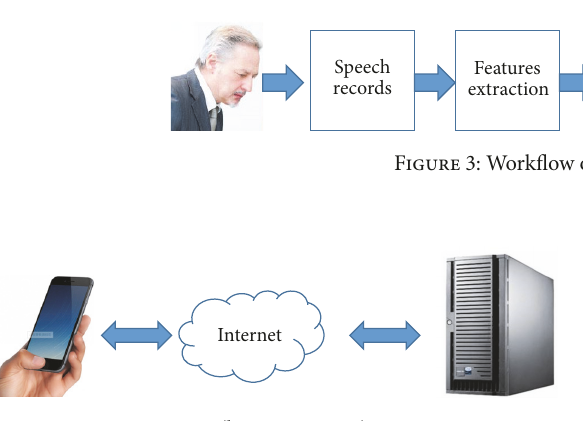
Figure 4: B/S (browser/server) structure.